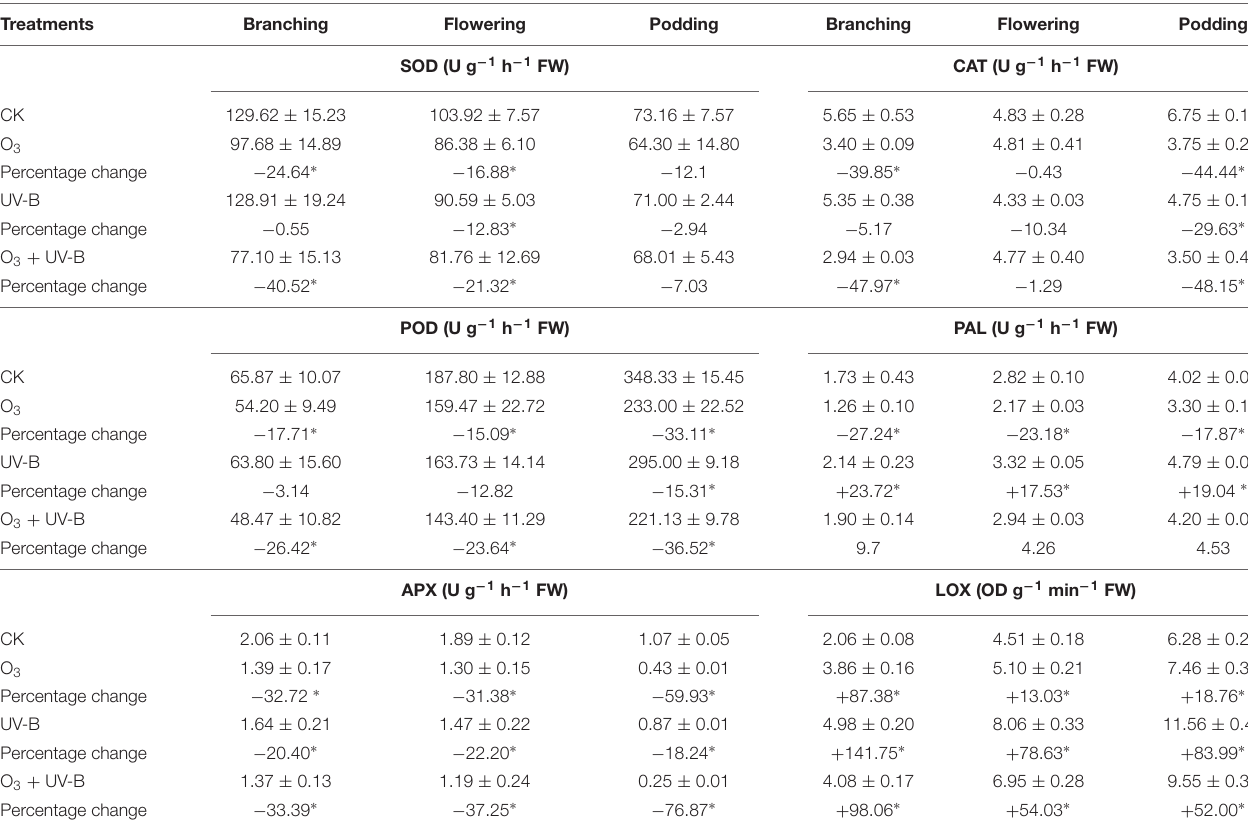
TABLE 3 | Differences in enzyme activities of soybean roots in response to control treatment (CK), elevated O 3 treatment (O 3 ), enhanced UV-B radiation treatment (UV-B) and O 3 + UV-B treatment (O 3 + UV-B) at stages of branching, flowering, and podding (mean ± SD, n = 3). Treatments Branching Flowering Podding Branching Flowering